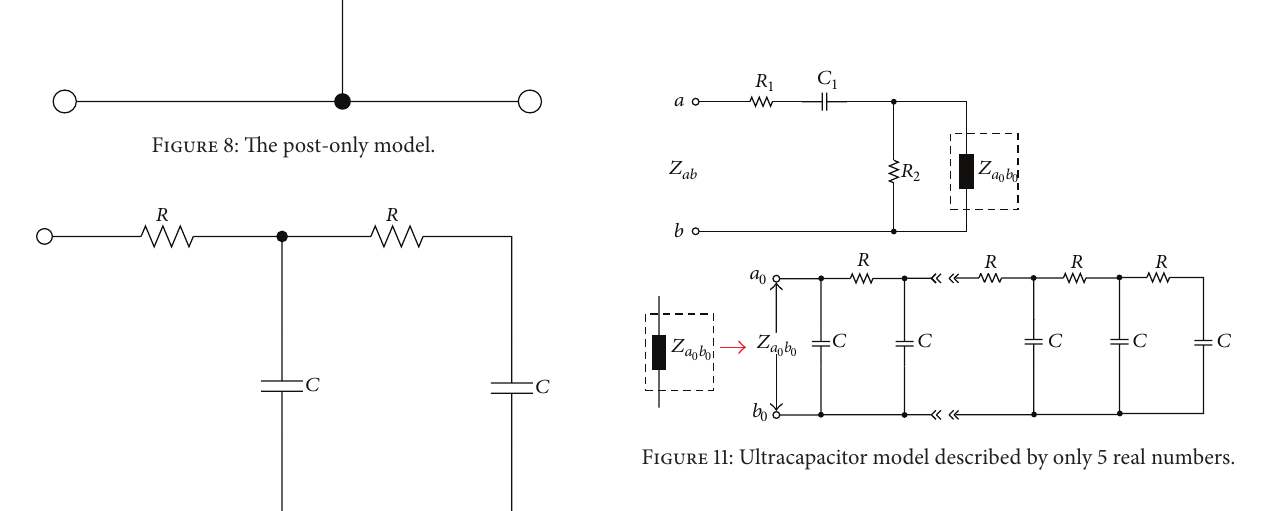
Figure 10: Electrical model of a fractal electrode structure.